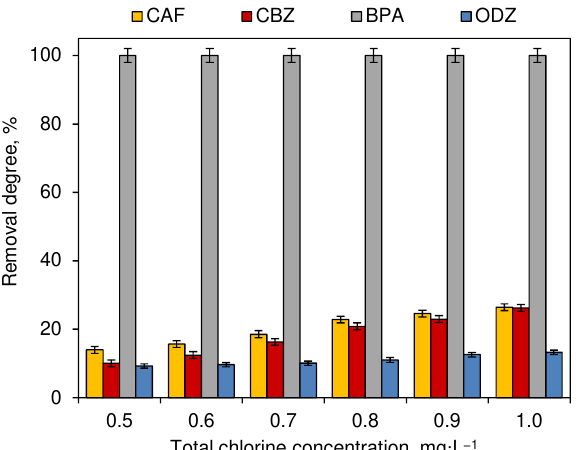
Figure 1. Influence of total chlorine concentration on the removal degree of CECs (dark chamber experiment, n = 3 where CAF—caffeine, CBZ—carbamazepine, BPA—bisphenol A, ODZ—oxadia- zon).